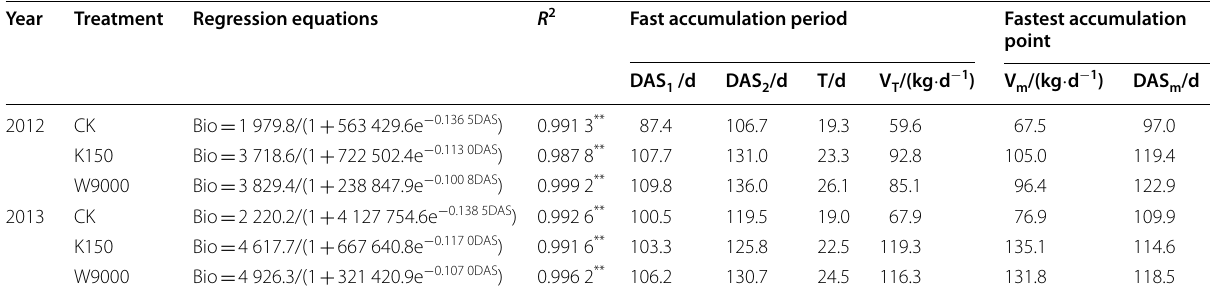
Table 2 The fitting of reproductive organ biomass accumulation and main eigenvalues of reproductive organ biomass accumulation for different treatments in 2012 and 2013